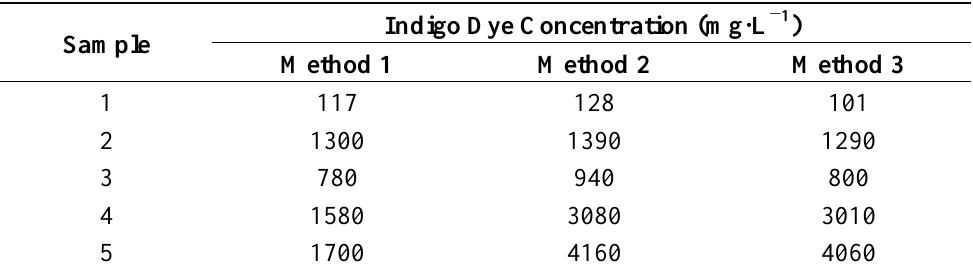
Table 4. Results from application of methods 1–3 to industrial